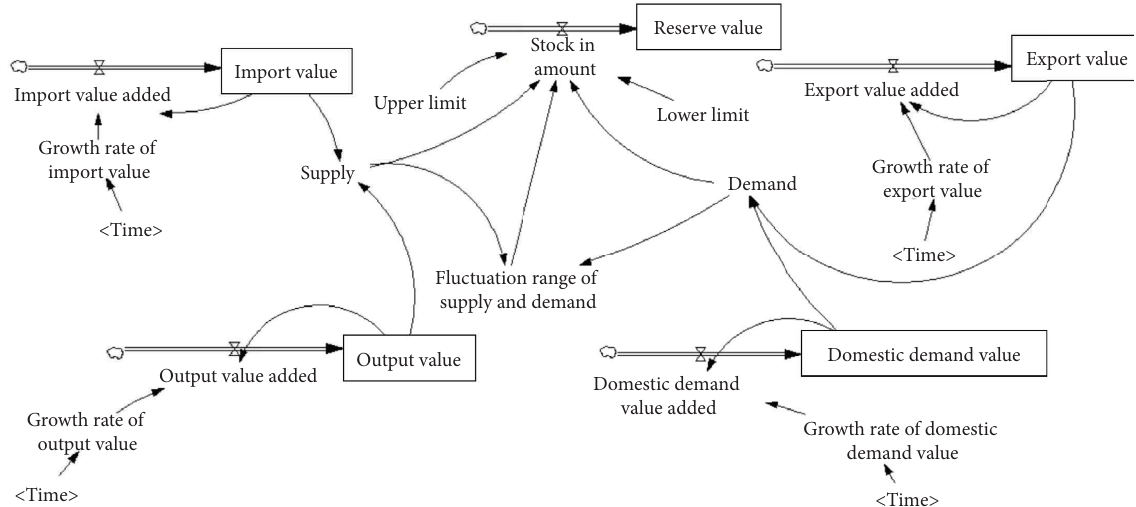
Figure 2: Flow chart of supply chain resilience system of mineral resources